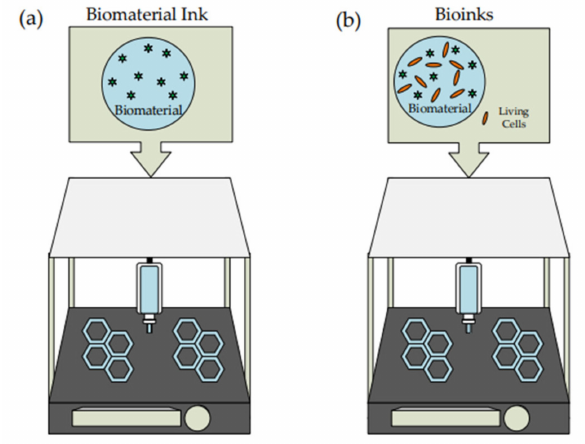
Figure 1. Difference between ( a ) 3D printing and ( b ) 3D bioprinting with the illustration using liquid deposition modeling (LDM)